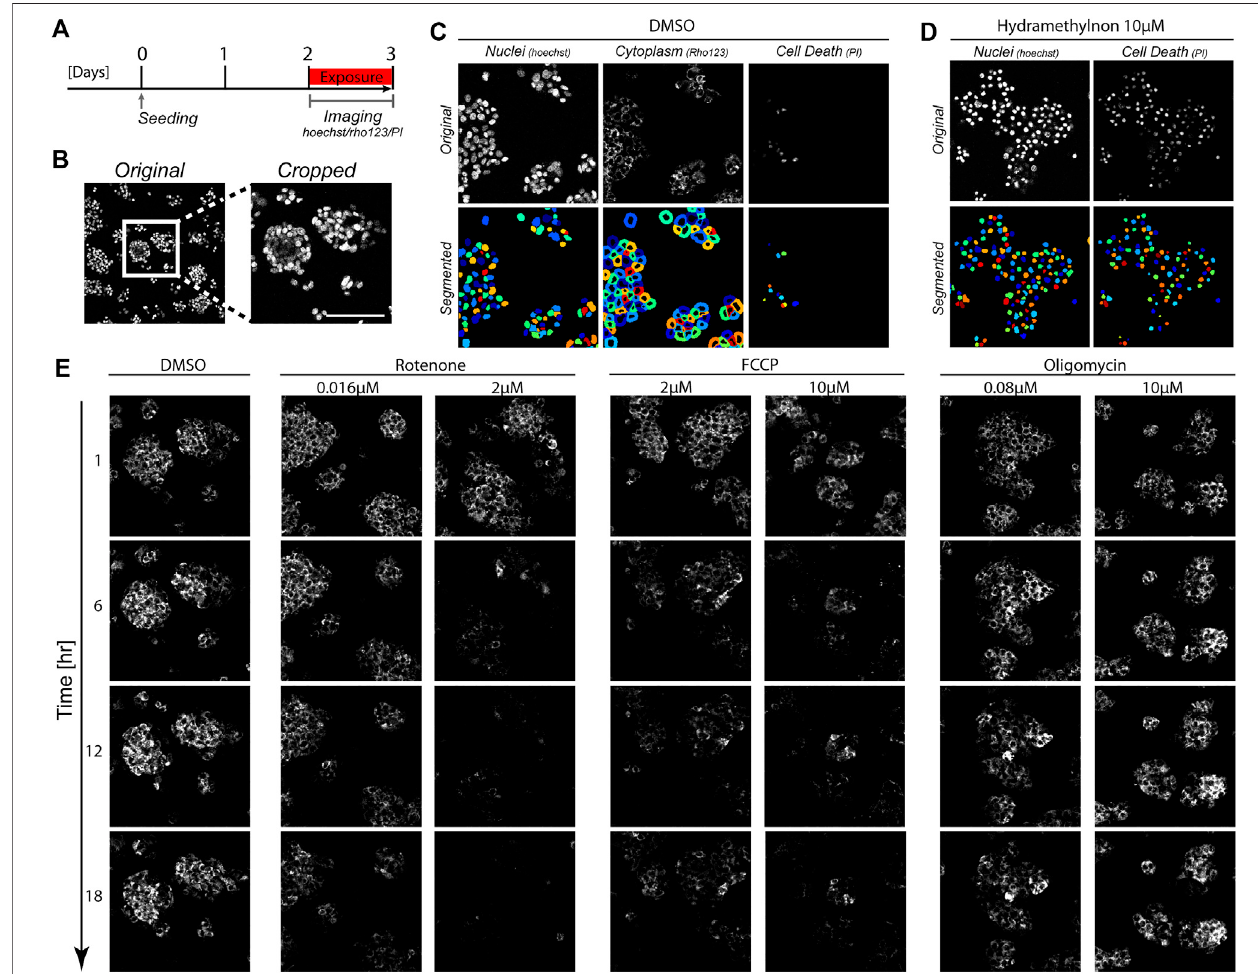
FIGURE 1| Image-based measurements over timein HepG2 cells. (A) Schematic representation of theexperimental set-up. HepG2 cells wereimaged for 24 h to track Rho123 (MMP), Hoechst (cell nuclei) and PI (necrosis) abundance following 2 days of cell seeding. (B) Representative images showing original image dimensions and a cropped image. (C, D) Images of Hoechst, Rho123 and PI staining (top panels) and the resulting segmentation from CellPro fi ler (bottom panels) . Images originate from a vehicle treated condition with 0.2%DMSO for 1 h (C) or a toxic condition with 10 μ M Hydramethylnon exposure for 24 h (D) . (E) Representative Rho123 images over time upon exposure to 0.2% DMSO, or to rotenone, antimycin A or oligomycin at the indicated concentrations for 1, 6, 12, and 18 h.